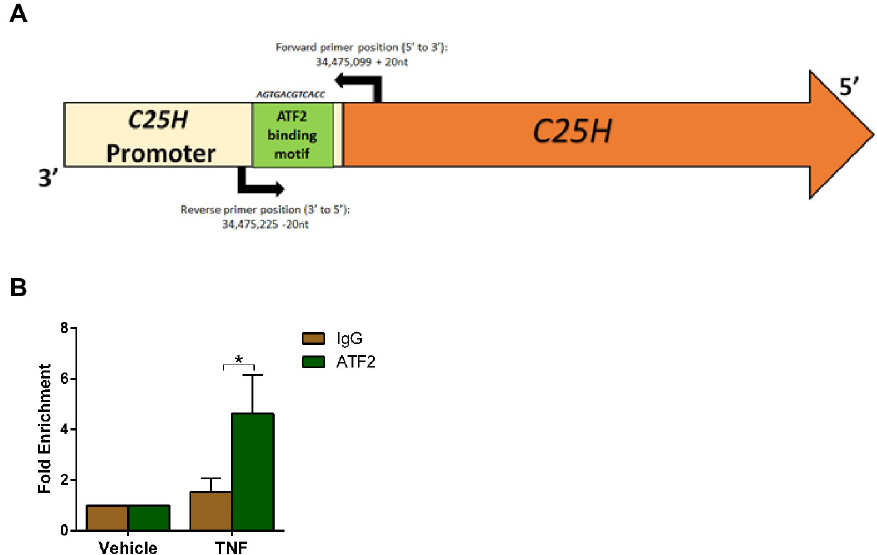
Fig 7. Direct binding of ATF2 transcription factor to the C25H promoter following activation of TNF signaling. (A) A schematic diagram of the mouse C25H promoter (light yellow) and mouse C25H gene (orange) is shown. ATF2 binding region is shown in green along with the ATF2 binding sequence in the C25H promoter. The arrows with numbers represent the position of the forward and reverse primers used for the ChIP-qPCR assay. (B) Chromatin was isolated from MEFs treated with TNF (10ng/ml) for 4h. ChIP-qPCR assay was performed by using ATF2 antibody, control IgG and primers to amplify the genomic region flanking the ATF2 binding site in the C25H promoter. Location of the primers is shown in Fig 7a. ChIP-qPCR data is shown as Mean ± SEM from three independent experiments (n = 3). � p � 0.05 using one-way ANOVA multiple comparison